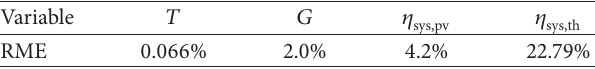
Table 4: The experimental RME of the